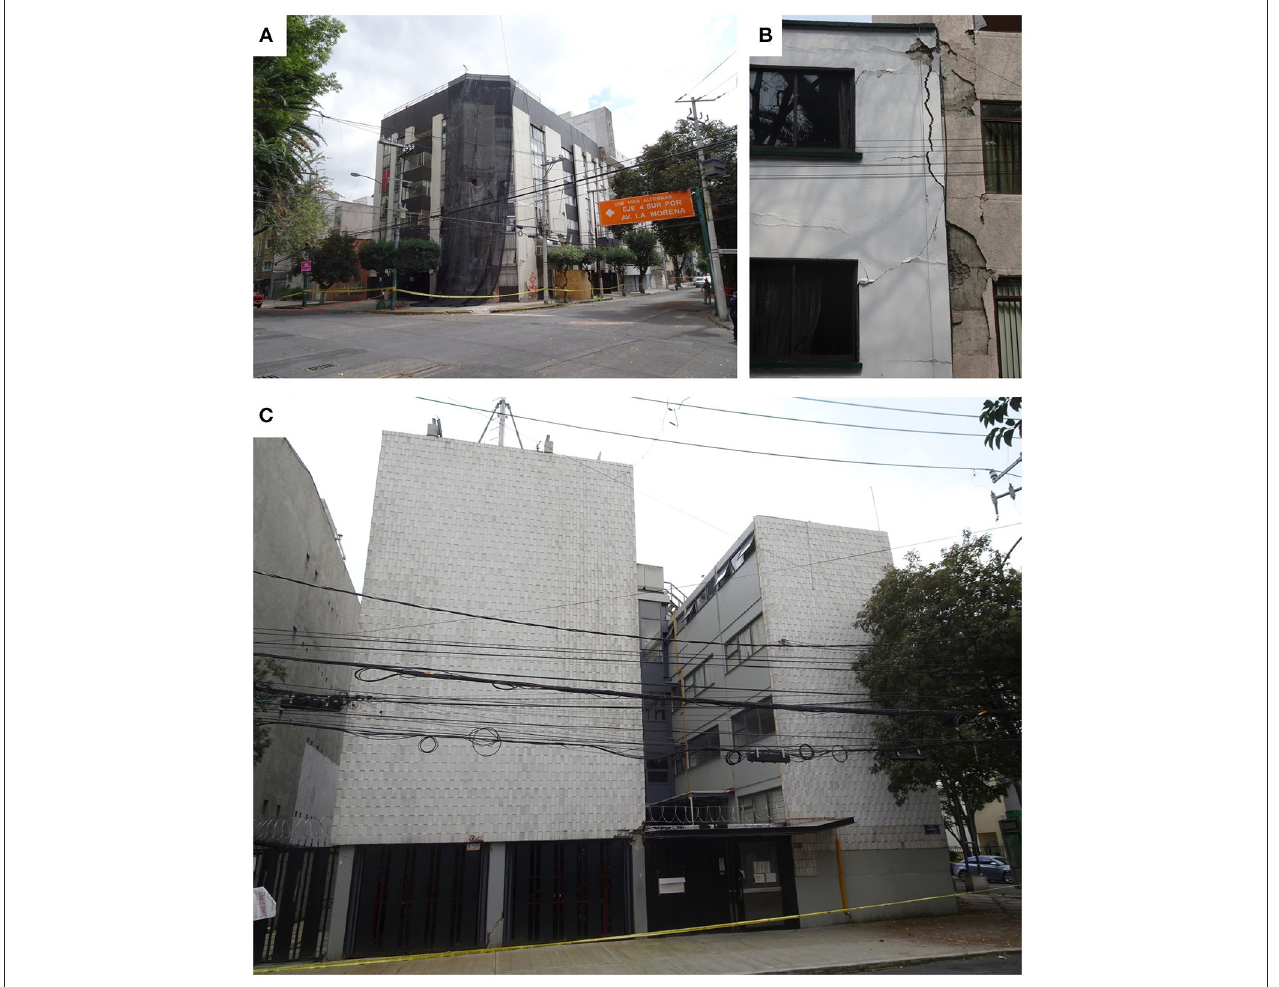
FIGURE 11 | Damage in La Morena. (A) Corner building with torsion eccentricity. (B) Pounding failure. (C) Soft storey in the ground floor.